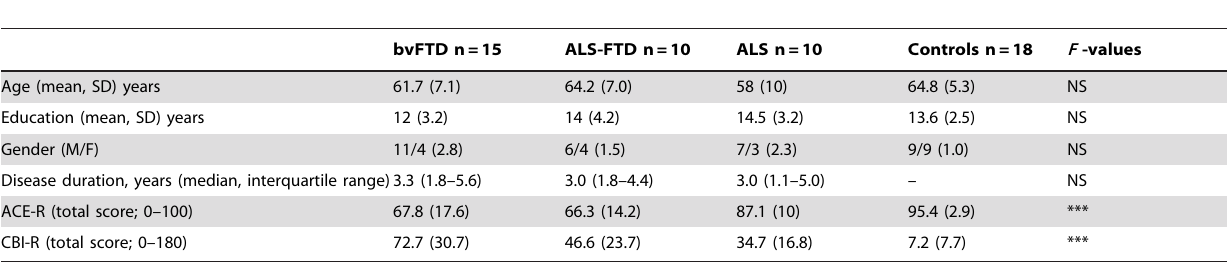
Table 1. Demographics, cognition and behaviour - Comparison on demographics and cognitive tests across ALS, bvFTD and ALS- FTD